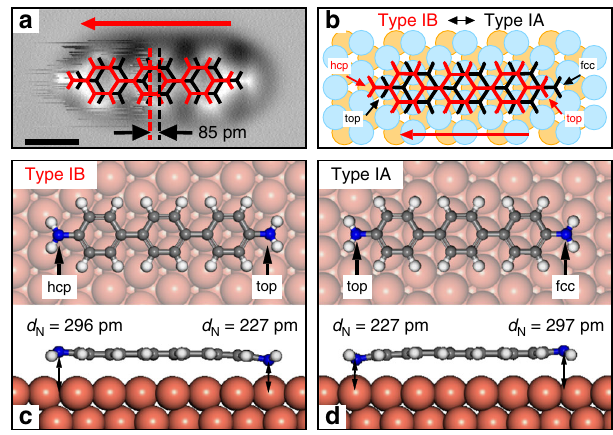
Fig. 3 Adsorption structure of DATP type I on Cu(111). a AFM image of DATP type I fi tted by two molecular models, namely type IA (black) and type IB (red). b Sketch of precise adsorption positions as determined by atomic resolution AFM scans (see Supplementary Fig. 6 for details). The two structures are displaced by 96 pm along the [11 − 2] direction. c , d DFT simulation of adsorption position type IA and type IB on Cu(111). Scale bar: 0.5 nm